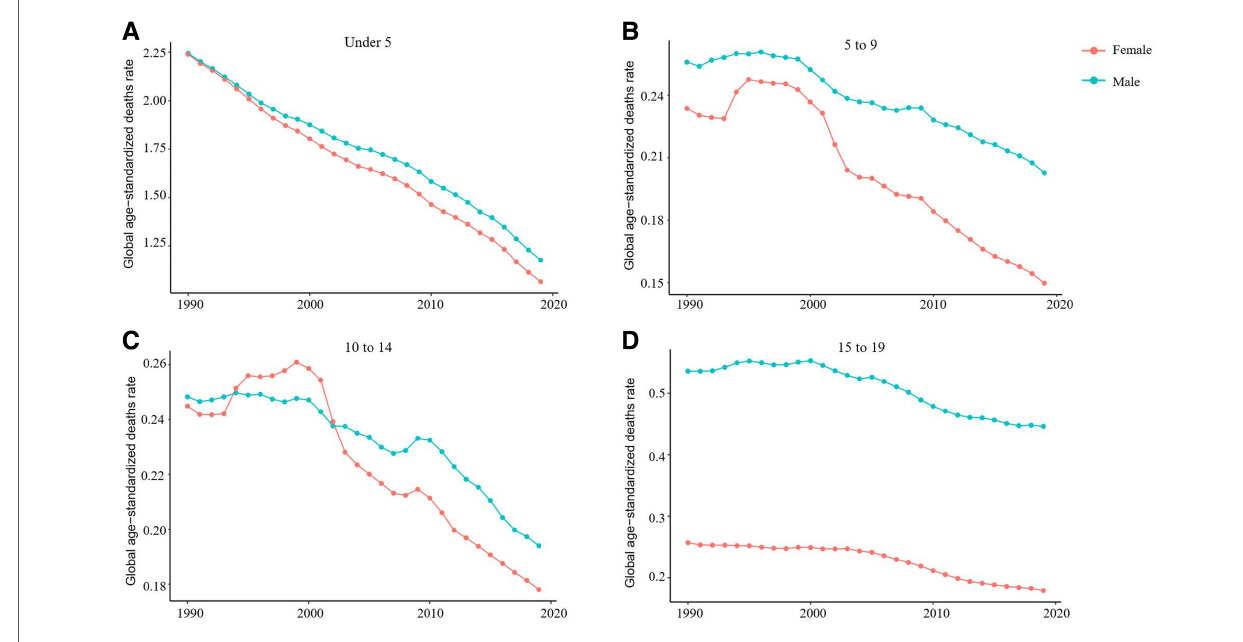
FIGURE 10 Change in trends of age-standardized death rate due to childhood myocarditis and cardiomyopathy by sex and age group from 1990 to 2019. ( A ) Change in trend of age-standardized death rate for under 5-year-olds. ( B ) Change in trend of age-standardized death rate for 5 – 9-year-olds. ( C ) Change in trend of age-standardized deaths rate for 10 – 14-year-olds. ( D ) Change in trend of age-standardized death rate for 15 – 19-year-olds.